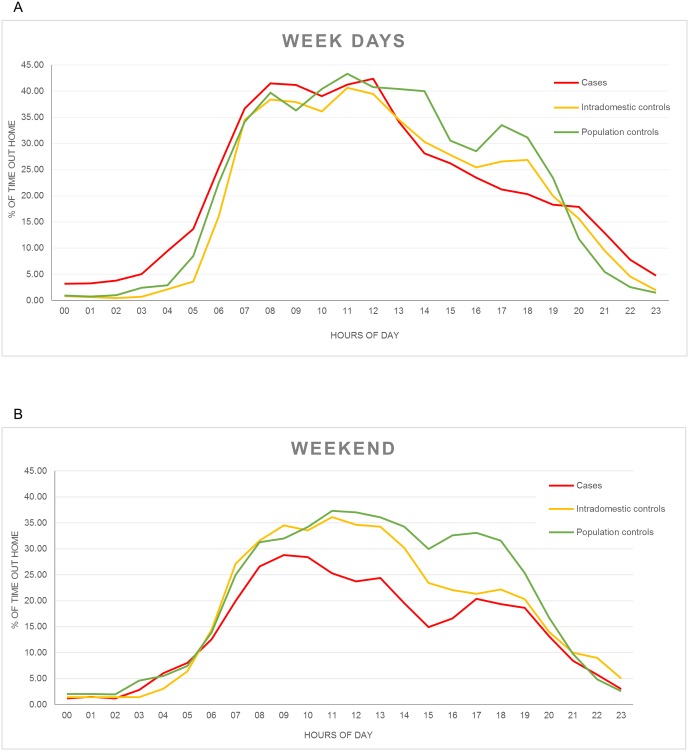
Hourly distribution of time spent out of home.(A) Proportion of time spent by the subjects out of their homes during weekdays (Monday to Friday). (B) Proportion of time spent by the subjects out of their homes during weekends (Saturday and Sunday). Y axis: Percentage of time out of the subject’s homes. X axis: hour of the day. Line colors: red depicts data of cases, yellow depicts intradomestic controls and green depicts population controls.